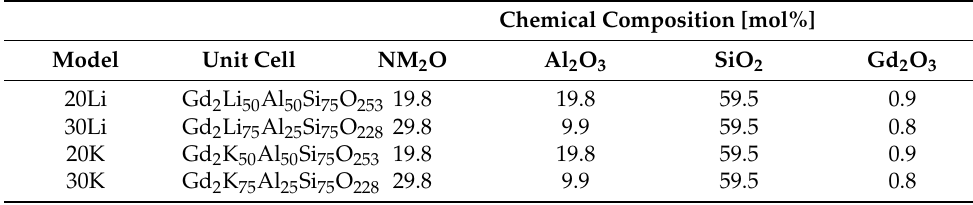
Table 2. Unit cell compositions of the glass structure